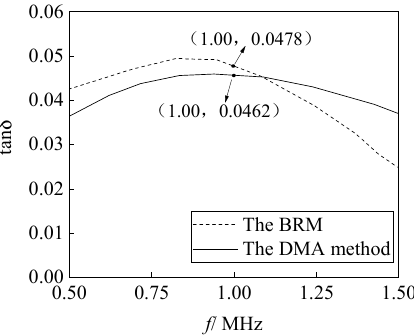
Figure 3. Loss tangent curve of the dynamic mechanical analysis (DMA) method and the bottom reflection method (BRM) in the effective frequency range of 0.5–1.5 MHz.